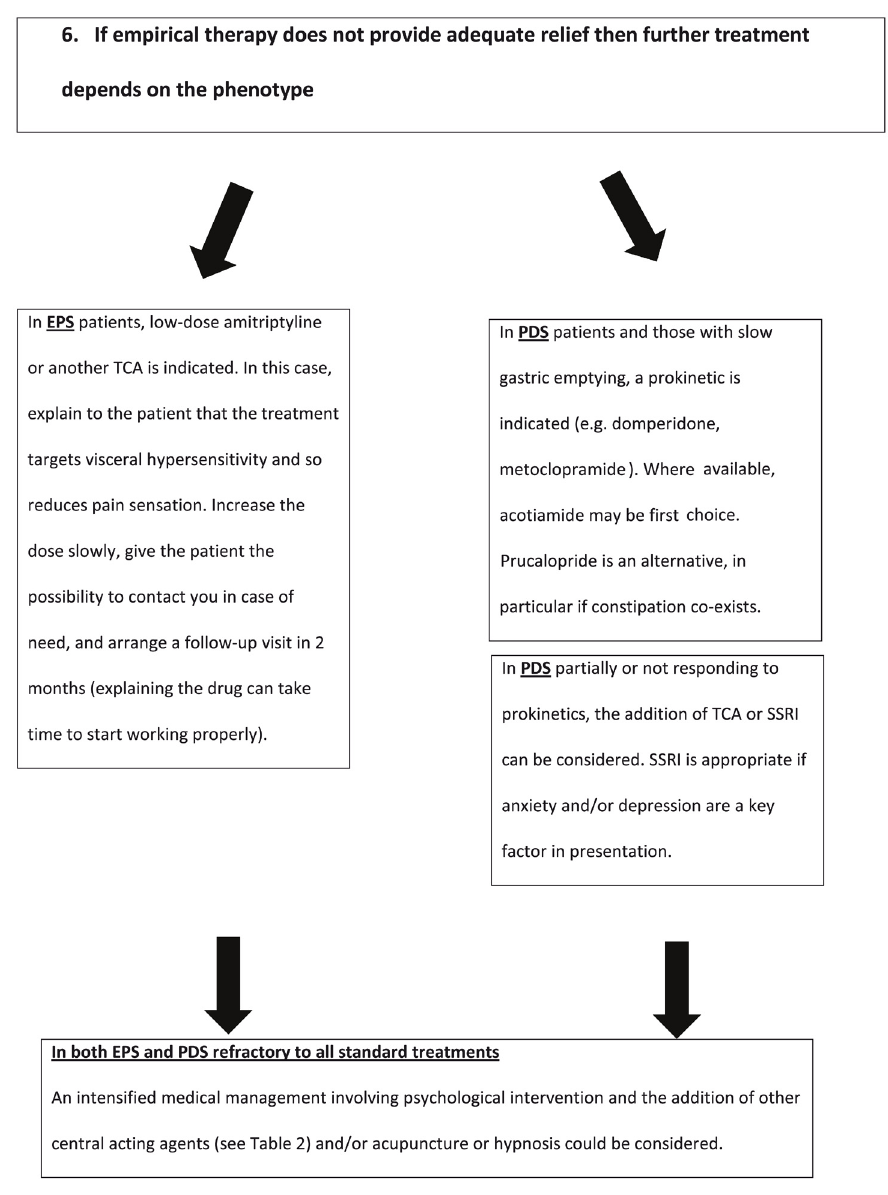
Figure 1. Practical management algorithm in functional dyspepsia. EPS, epigastric pain syndrome; FD, functional dyspepsia; FODMAP, fermentable oligosaccharides, disaccharides, monosaccharides, and polyols; GERD, gastro-oesophageal reflux disease; GI, gastrointestinal; IBS, irritable bowel syndrome; PDS, postprandial distress syndrome; SSRI, selective serotonin reuptake inhibitor; TCA, tricyclic